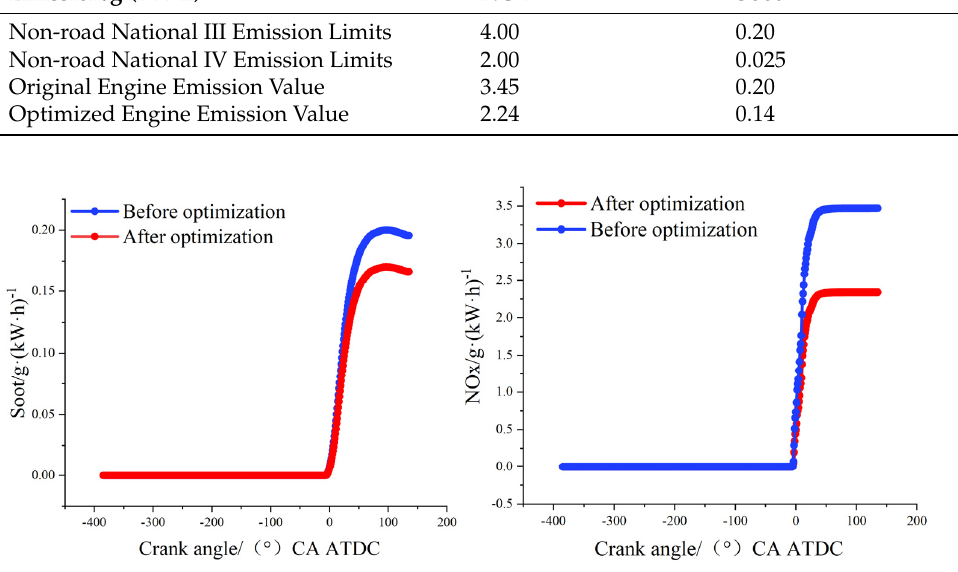
Figure 8. Comparison of combustion chamber emission